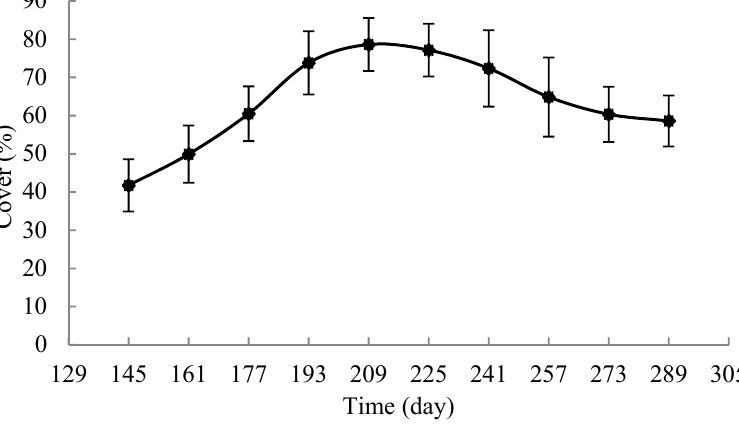
Figure 4. Spatial distribution of the average grassland cover for days 145–289 (per 16 days), in Gannan, from 2000 to 2016.